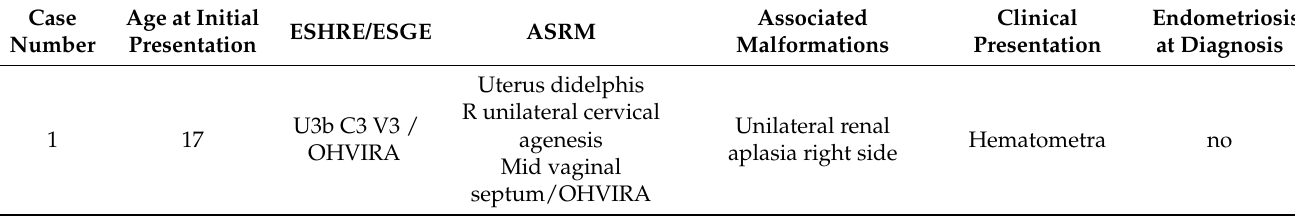
Table 1. Patient